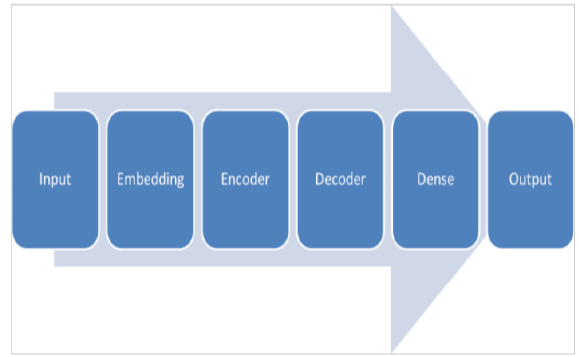
Figure 2. System Design of Neural Machine